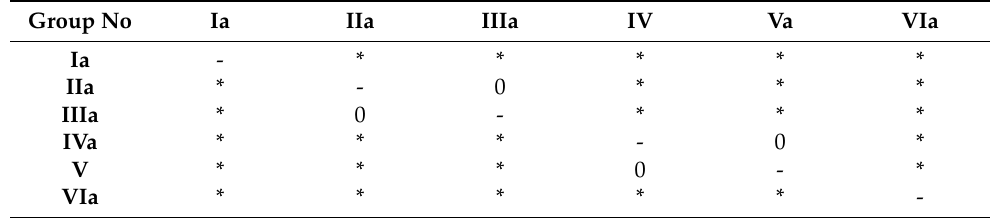
Table A7. The capsule’s surface area and capillary tuft in kidneys of animals in high cholesterol diet. Statistical differences between all experimental groups; * significant, 0 insignificant. Group No